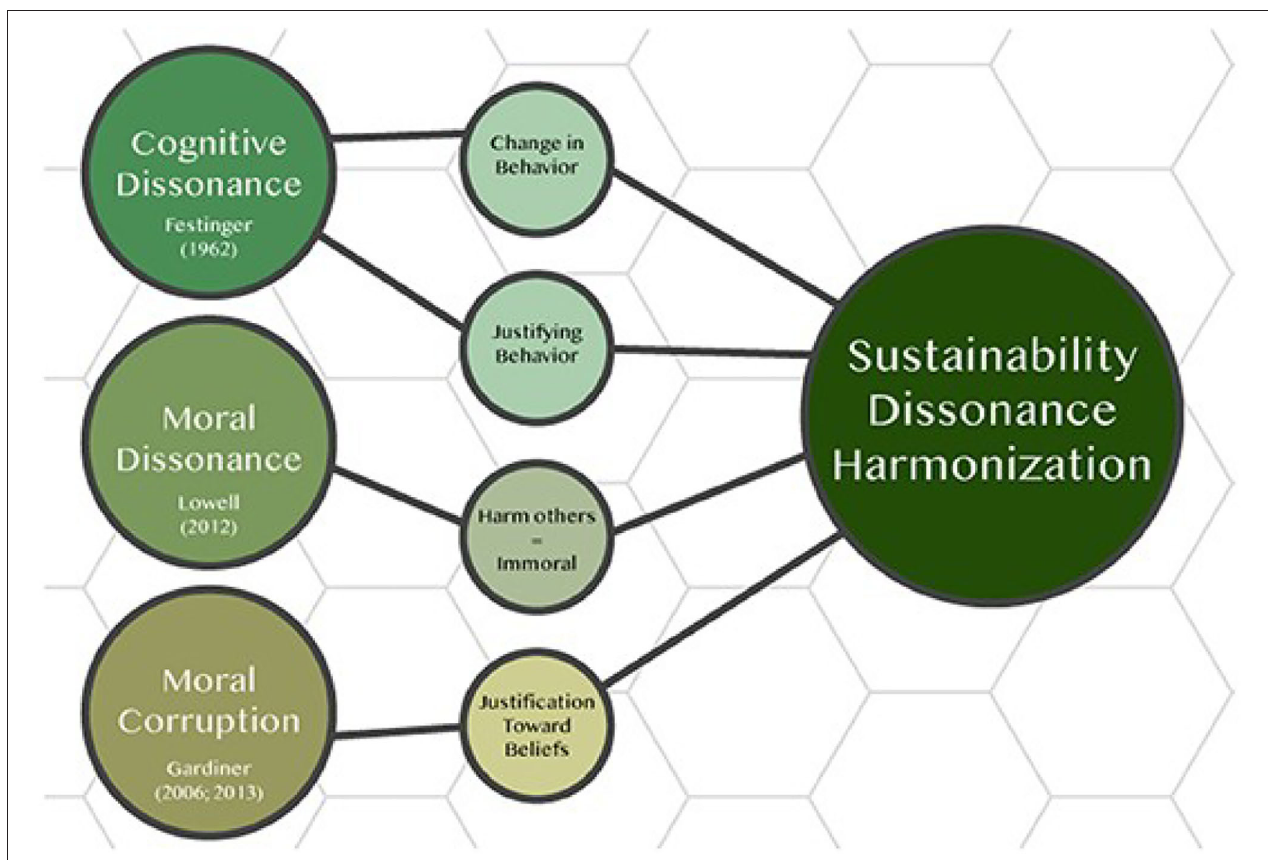
FIGURE 1 | Demoralization in decision making by harmonization strategies (Weder et al.,